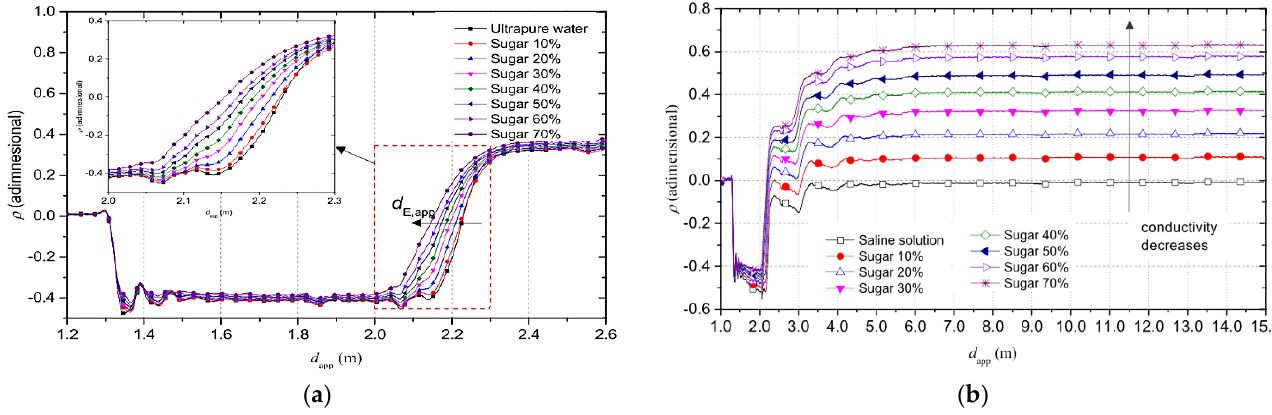
Figure 15. TDR reflectogram, ( a ) for ultra-pure water and ( b ) saline solutions with different sugar concentrations [48].